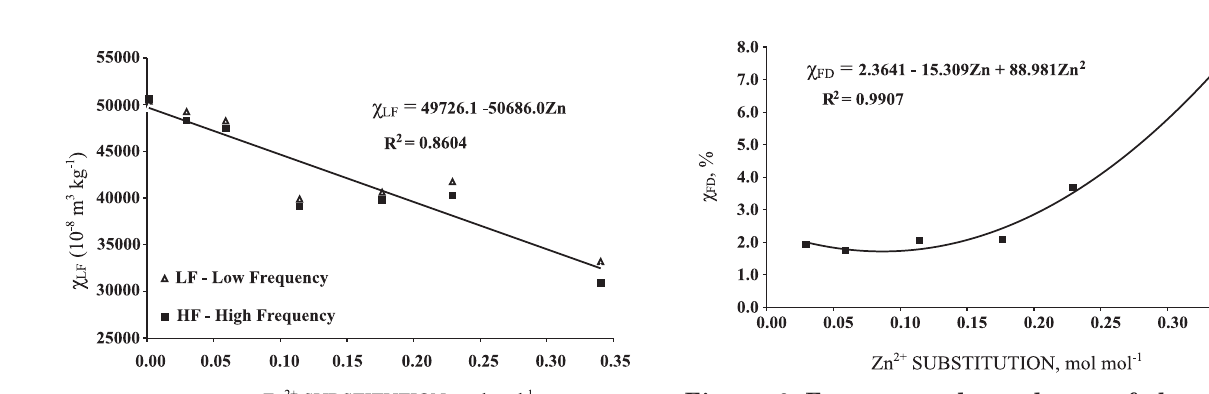
Figure 6. Frequency dependence of the mass- specific magnetic susceptibility ( XXXXX LF synthetic maghemites with different zinc isomorphic substitution